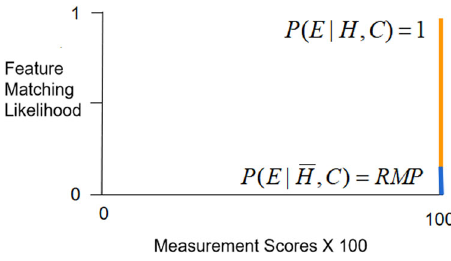
Fig. 3 Simple feature-matching measurements. Matching